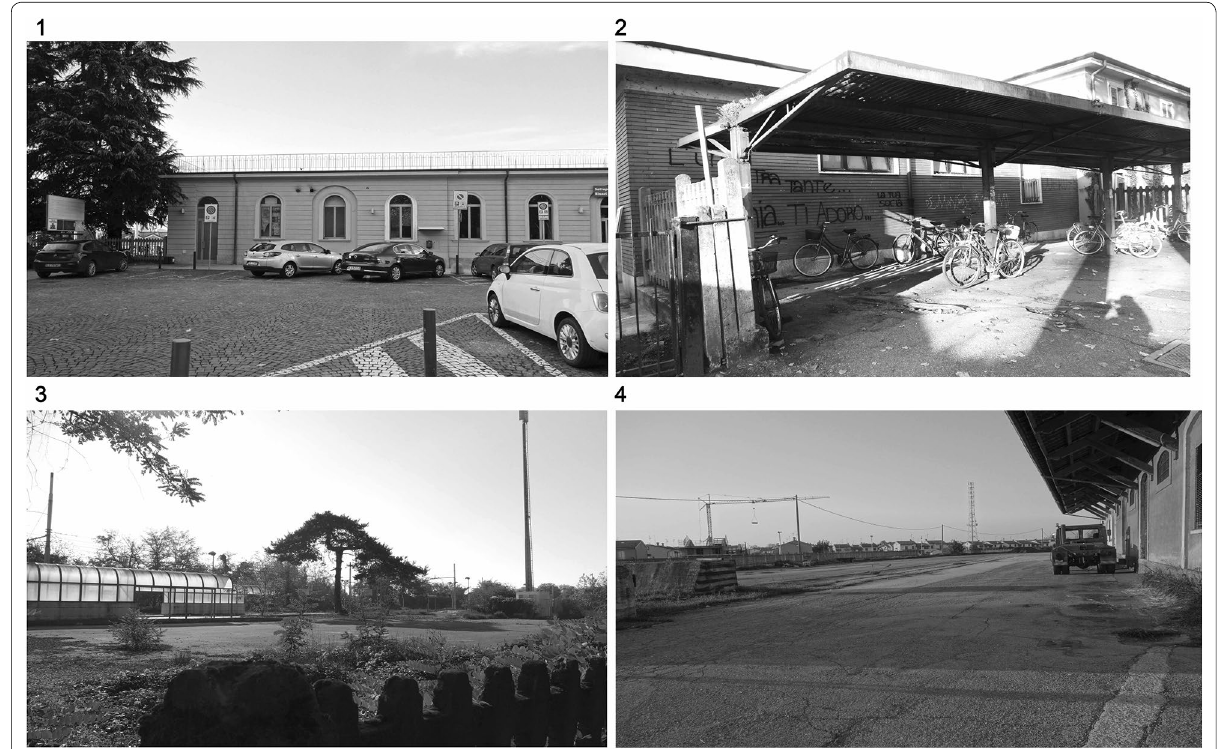
Fig. 8 External spaces related with stations (1. Tortona, 2. Codogno, 3. Pizzighettone, 4.